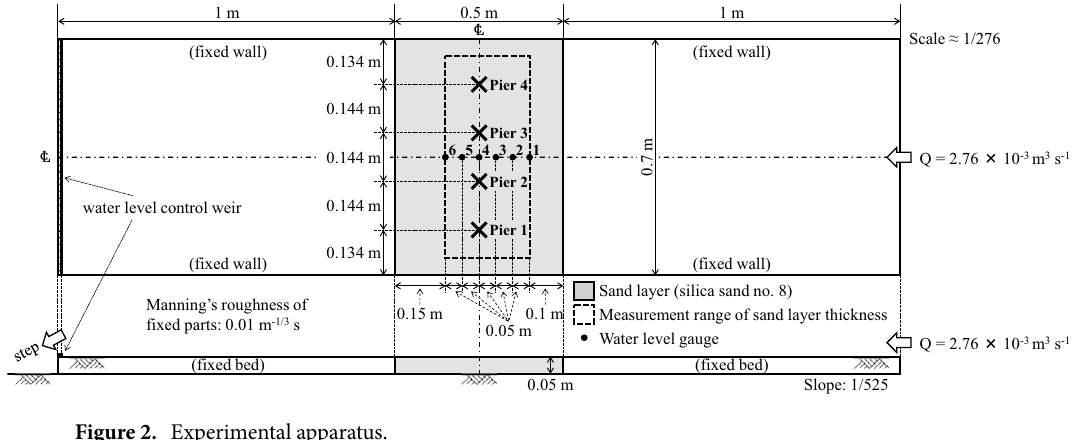
Figure 2. Experimental